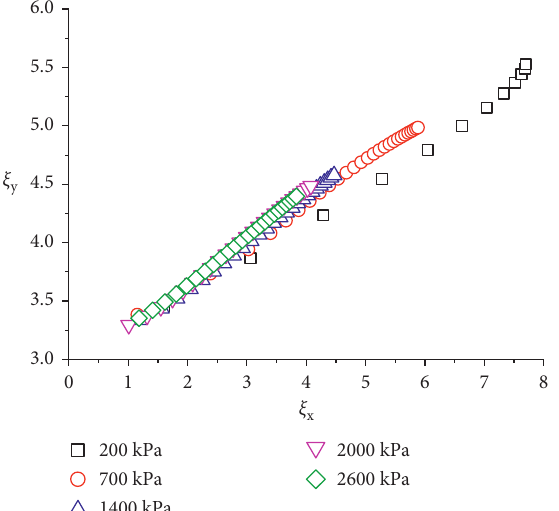
Figure 8: CP tests of Yixing rockfill materials [27].